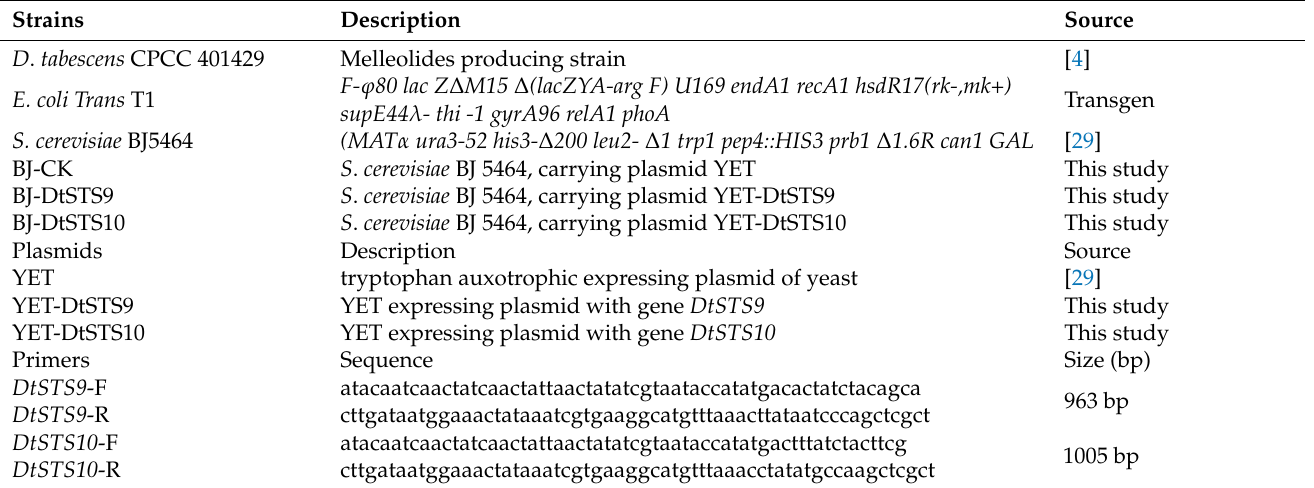
Table 1. Strains, primers, genetically engineered yeast in the